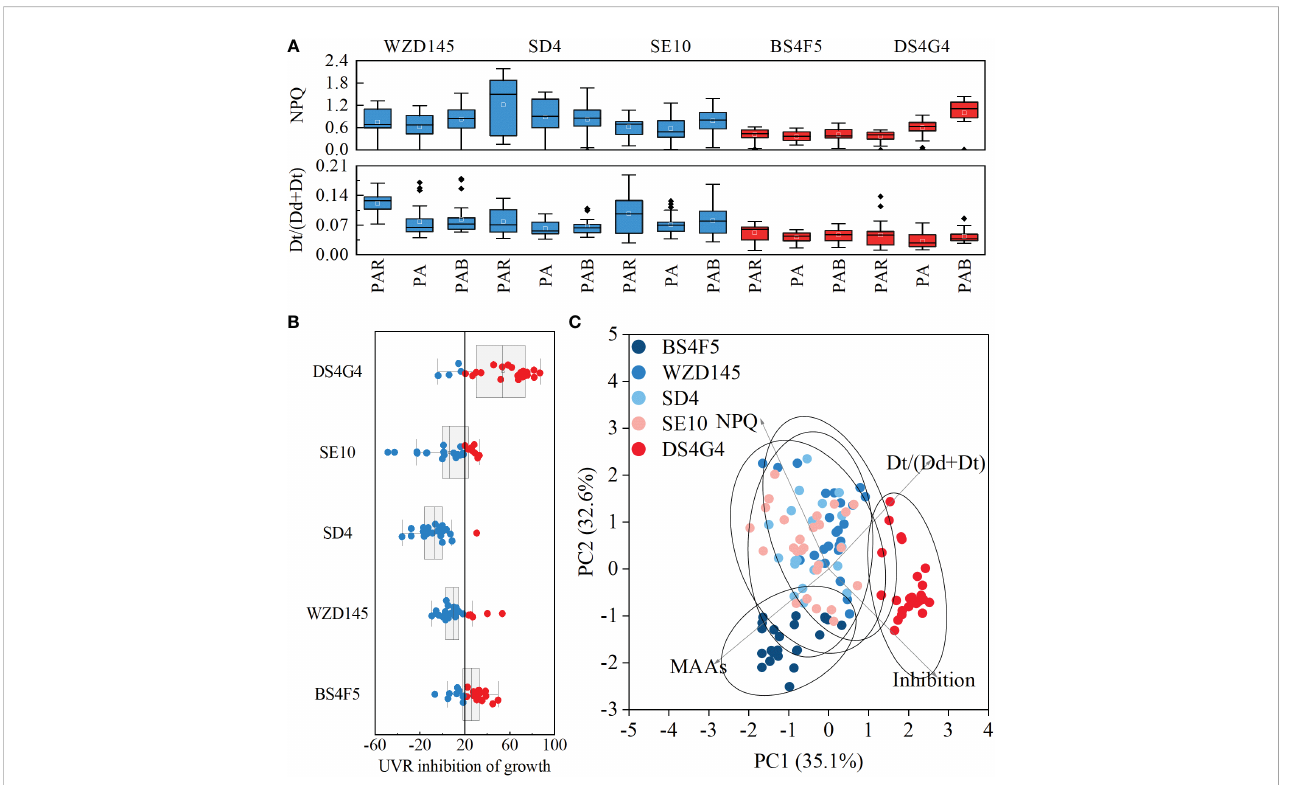
FIGURE 3 The relationship between photoprotection and UVR inhibition among fi ve strains of P. lima complex and P. caipirignum (strain SE10). Non-photochemical quench (NPQ) and de-epoxidation rates [Dt/(Dd+Dt)] between diadinoxanthin (Dd) and diatoxanthin (Dt) among fi ve strainsunder PA, PAB, and PAR, with red indicating a relatively low group and blue indicating a relatively high group, n = 21 or 27 (A) ; The inhibition of UVR on growth among fi ve strains, with red points indicating values higher than 20% (B) ; principal component analysis suggests interspecies differences across fi ve strains (C)